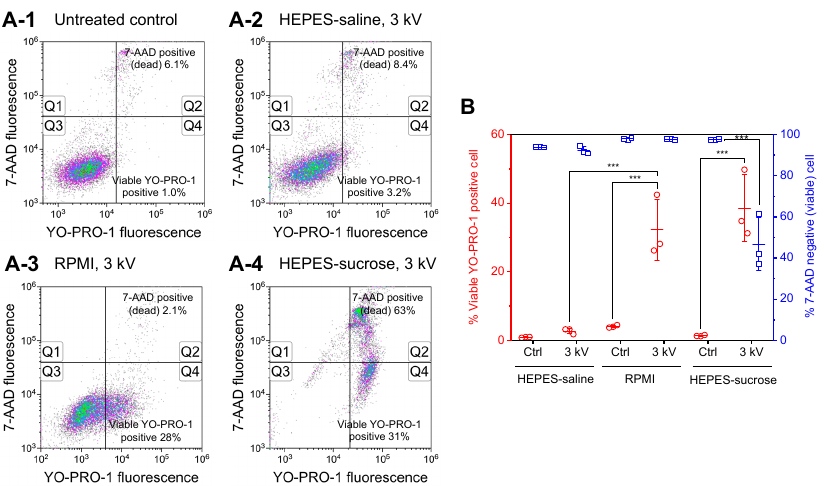
Figure 3. Uptake of YO-PRO-1 molecules measured by flow cytometry. ( A-1 – A-4 ) Intensity of fluorescence of YO-PRO-1 and 7-AAD was measured and plotted using a log scale. The percentages of 7-AAD-positive (dead) cells (Q1 + Q2) and YO-PRO-1-positive viable cells (Q4) are shown. ( B ) The population of YO-PRO-1-positive viable cells and cell viability after short-circuiting using different electroporation media, as determined using flow cytometry. Data are expressed as the mean ± SD of three independent measurements. Statistical significance was determined using one-way ANOVA followed by Tukey’s multiple comparison tests, ∗∗∗ p < 0.001.